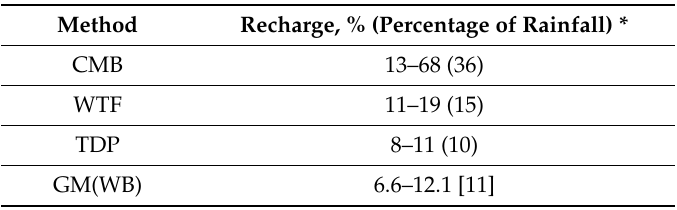
Table 5. Summary of recharge estimation using di ff erent